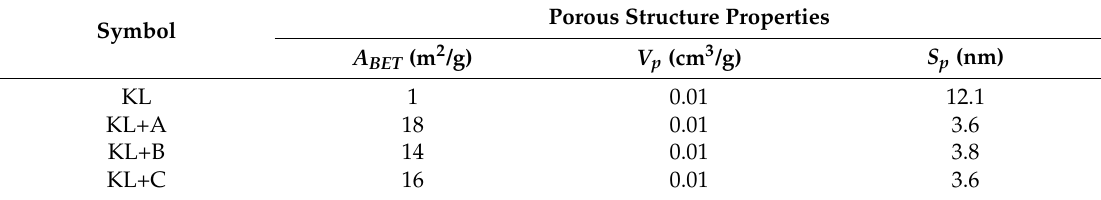
Table 3. Parameters of porous structure of pure kraft lignin (KL) and products activated in selected